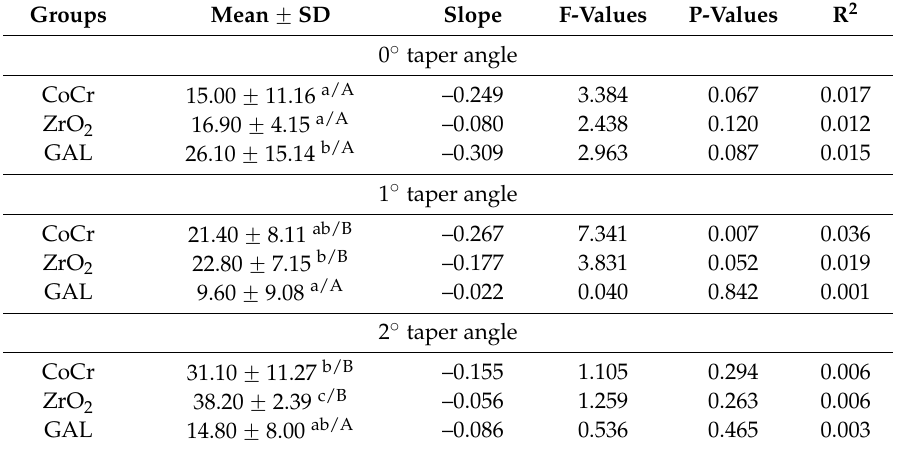
Table 2. Mean retention force values (N), one-way ANOVA results and slopes with corresponding F/P and R 2 values according to linear regression for all tested